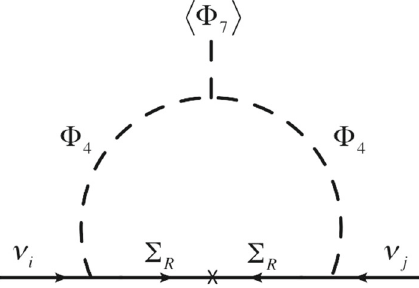
Fig. 2 Contribution to neutrino masses at one-loop